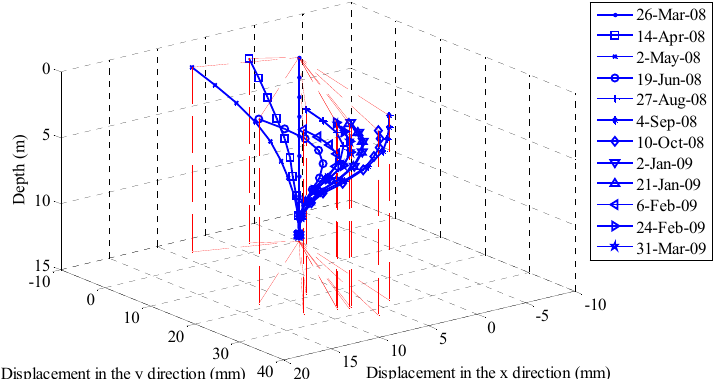
Figure 8. Monitoring results of slope movements (adapted from [15]).